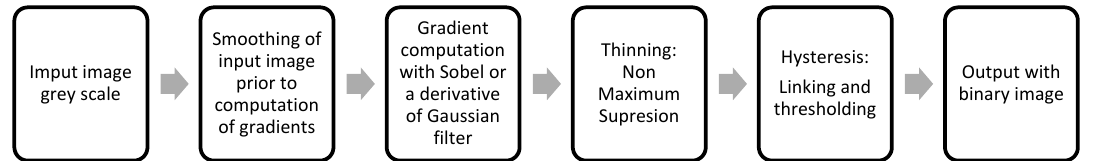
Figure 1. Processing steps of Canny edge-detection method.